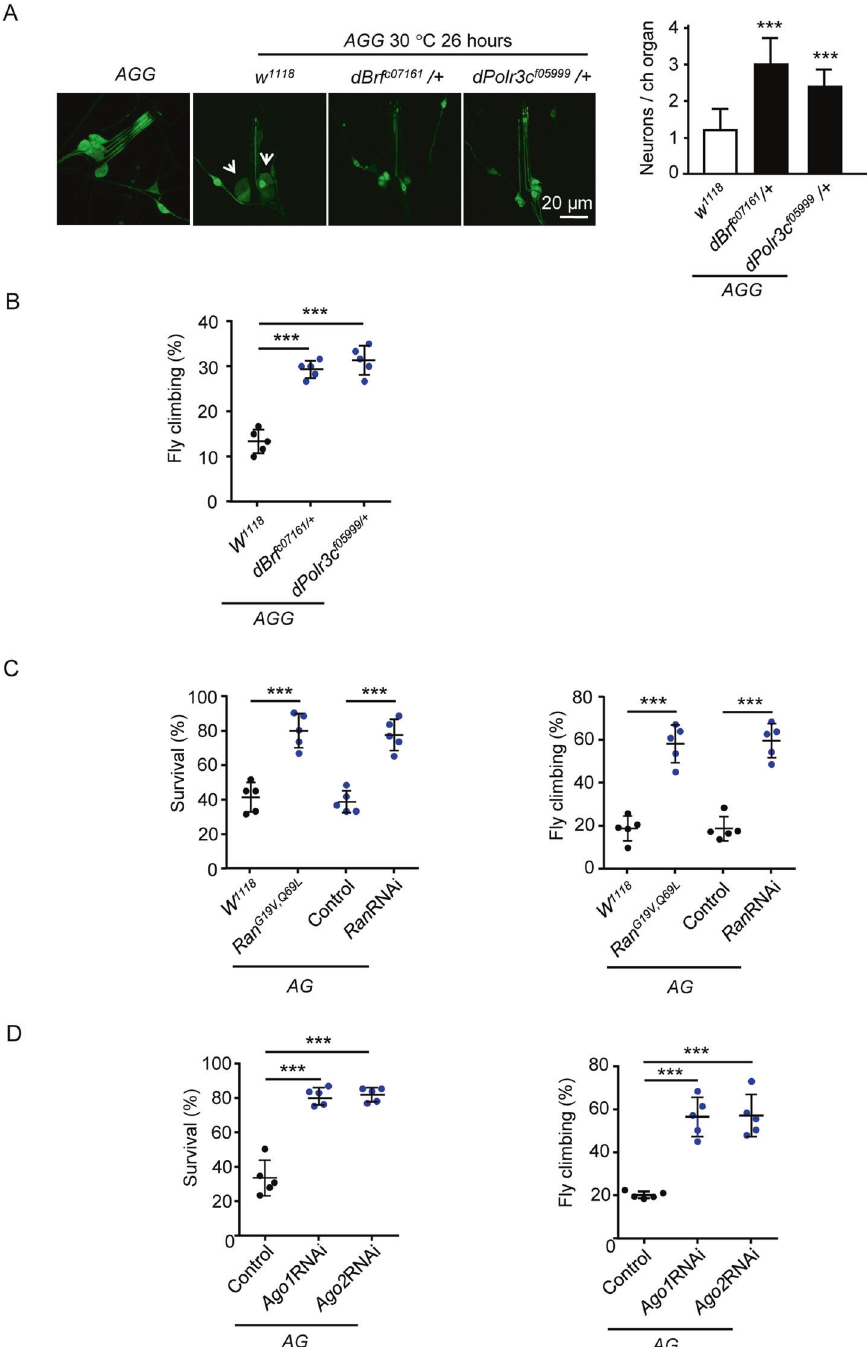
Fig. 6 The Drosophila model of neuronal necrosis. A Effect of mutations in the RNA polymerase III complex on neuronal necrosis. The images are samples of one chordotonal organ neuron (Ch N), which contains six sensory neurons in a cluster. Compared to the wild-type fl ies, the activation of neuronal necrosis resulted in Ch N loss in the AGG ( Appl-Gal4 / + ; UAS-GluR1 Lc , tubulin-Gal80 ts / + ; UAS-GFP / + ) fl ies. The white arrows point to the swollen neurons. In the mutants under the AGG background ( Appl-Gal4 / + ; UAS-GluR1 Lc , tubulin-Gal80 ts / + ; UAS-GFP / dBrf c07161 and Appl-Gal4 / + ; UAS- GluR1 Lc , tubulin-Gal80 ts / + ; UAS-GFP / dPolr3c f05999 ), the average number of Ch N was plotted. n = 25 chordotonal organs from fi ve larvae. B The climbing ability of AGG fl ies under the mutant background same as ( A ). Trial n = 5, 50 − 60 fl ies were tested for each trial. C The survival and climbing ability of AG (genotype: Appl-Gal4 / + ; UAS-GluR1 Lc , tubulin-Gal80 ts / + ; + / + ) fl ies under the mutant or RNAi background (genotype: Appl-Gal4 / + ; UAS- GluR1 Lc , tubulin-Gal80 ts / Ran G19V,Q69L ; + / + and Appl-Gal4 / + ; UAS-GluR1 Lc , tubulin-Gal80 ts / + ; UAS-RanRNAi / + ). Besides the control under the mutant background ( w 1118 ), a genetic background matched RNAi control (TB00072) was also used. This line contains an insert of the transgenic vector into the de fi ned site on chromosome 3. Trial n = 5, 50 − 60 fl ies were tested for each trial. D The survival and climbing ability of AG fl ies under the Ago1RNAi and Ago2RNAi background (genotype: Appl-Gal4 / + ; UAS-GluR1 Lc , tubulin-Gal80 ts / UAS-Ago1RNAi ; + / + and Appl-Gal4 / + ; UAS-GluR1 Lc , tubulin- Gal80 ts / UAS-Ago2RNAi ; + / + ). A genetic background matched RNAi control (TB00073) was also used. This line contains an insert of the transgenic vector into the de fi ned site on chromosome 2. Trial n = 5, 50 − 60 fl ies were tested for each trial.